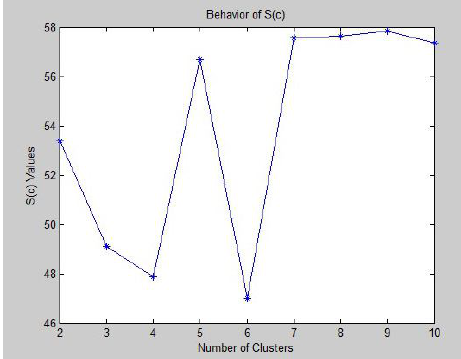
Fig. 3. Clustering User Profiles